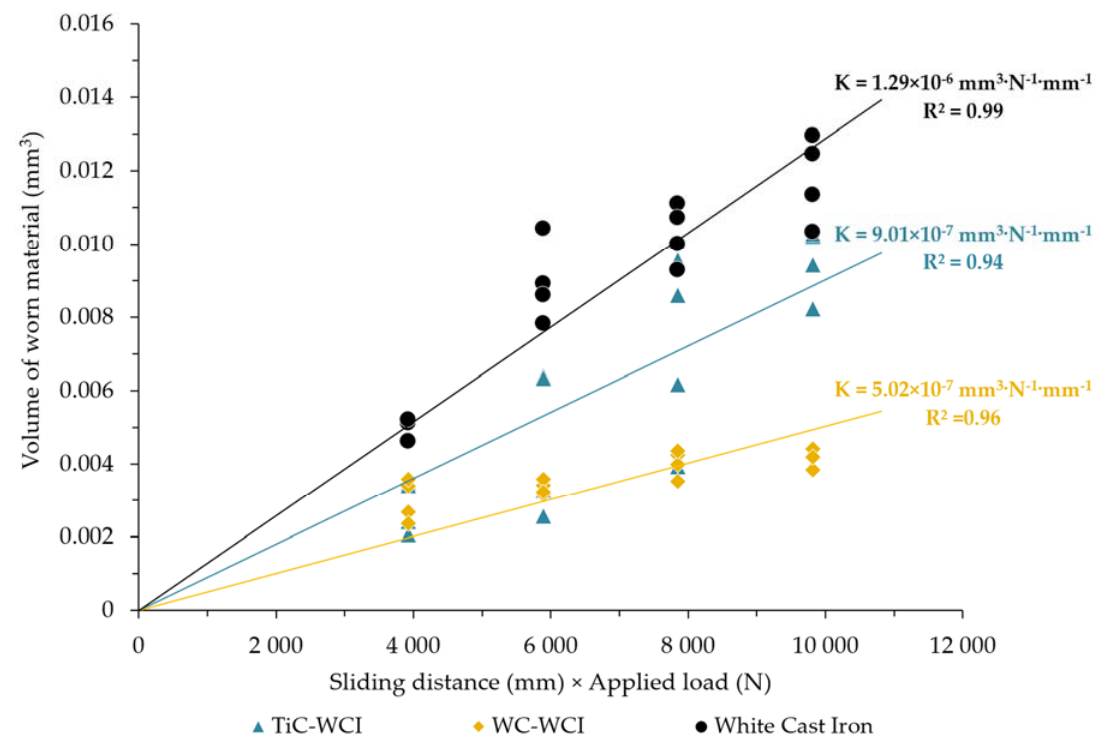
Figure 7. Volume of worn material as a function of the sliding distance under a constant load of 0.25 N for the reinforcements and the base metal.